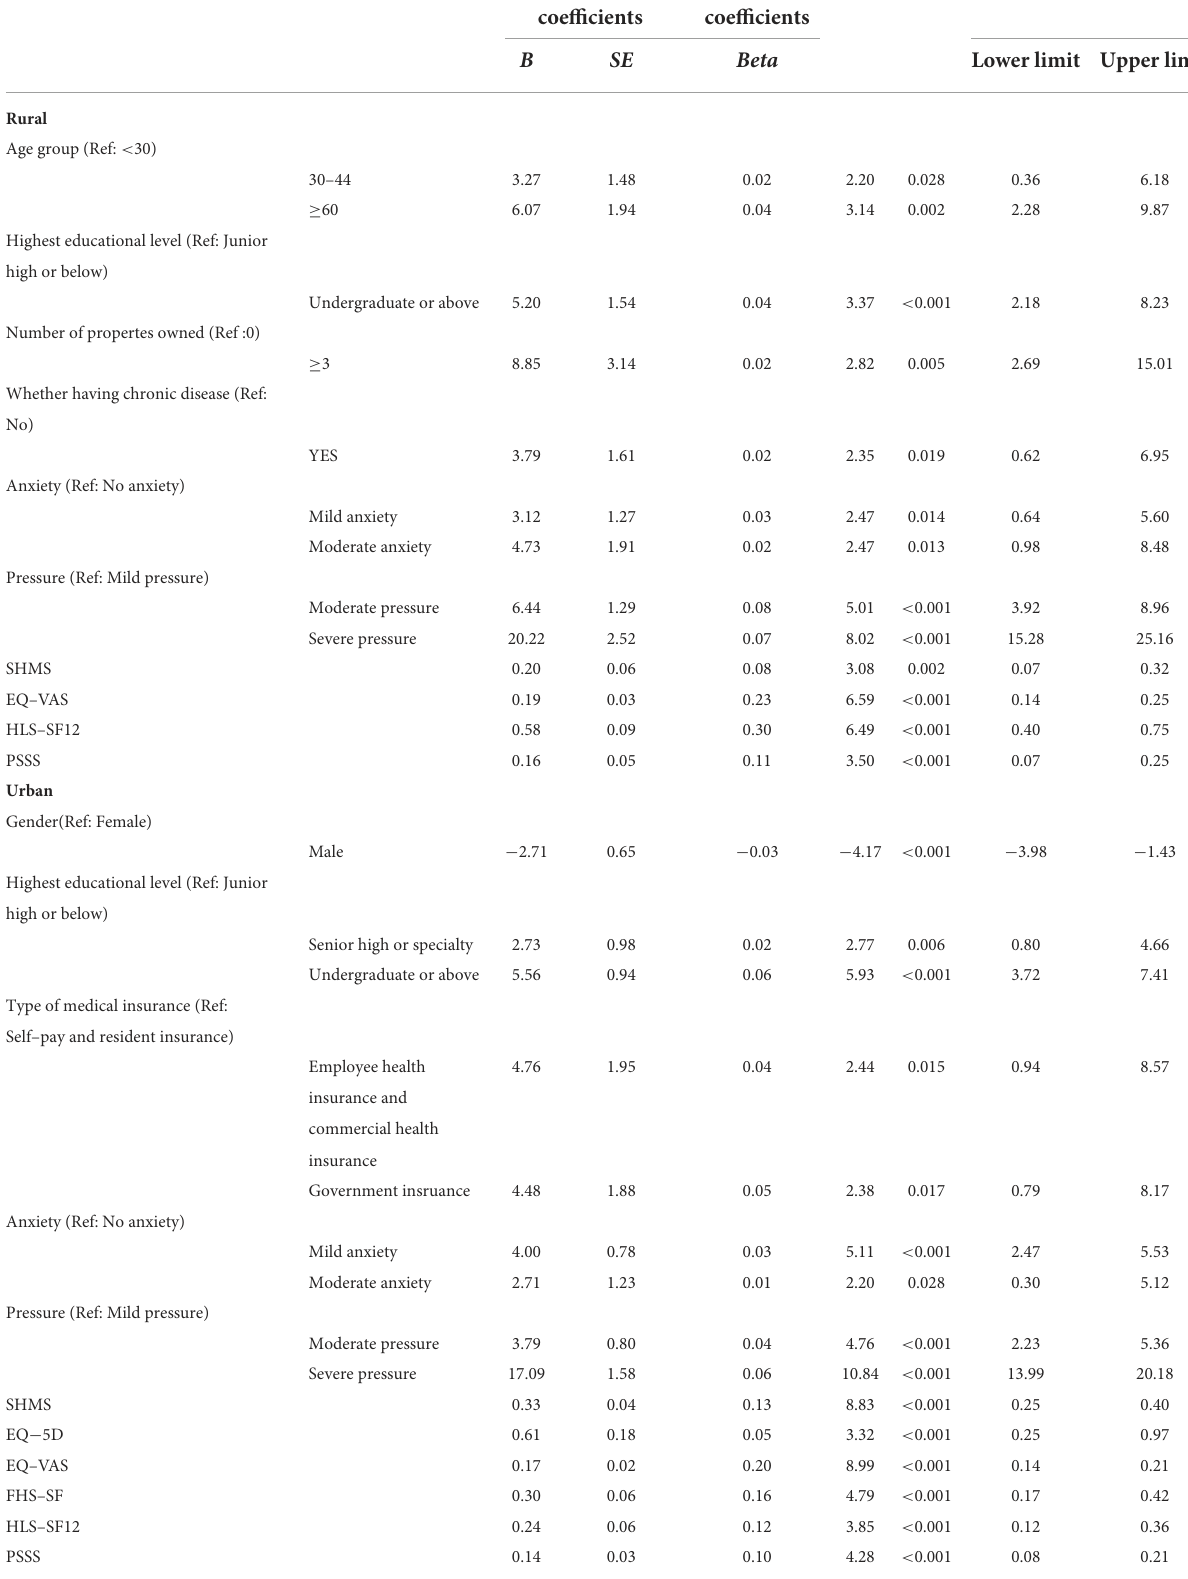
TABLE 4 Hierarchical stepwise regression analysis of predictors of hospice acceptance by place of residence.